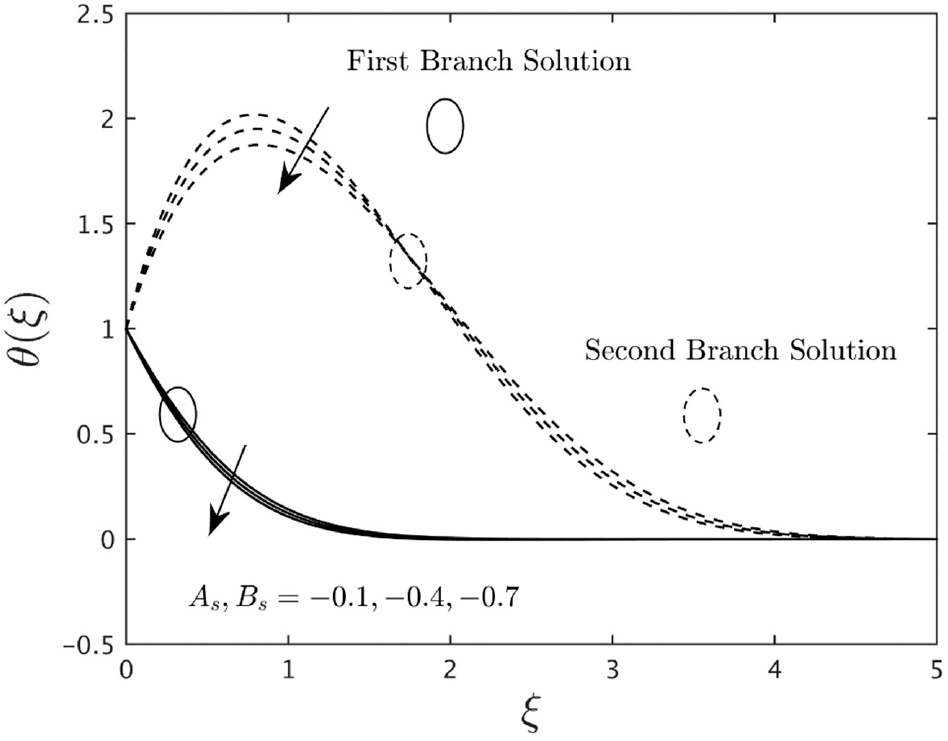
Figure 16. Temperature profile for the several values of A s , B s < 0.